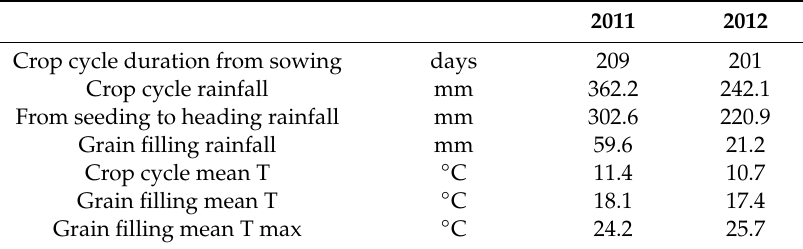
Table 3. Climatic data related to the two experimental